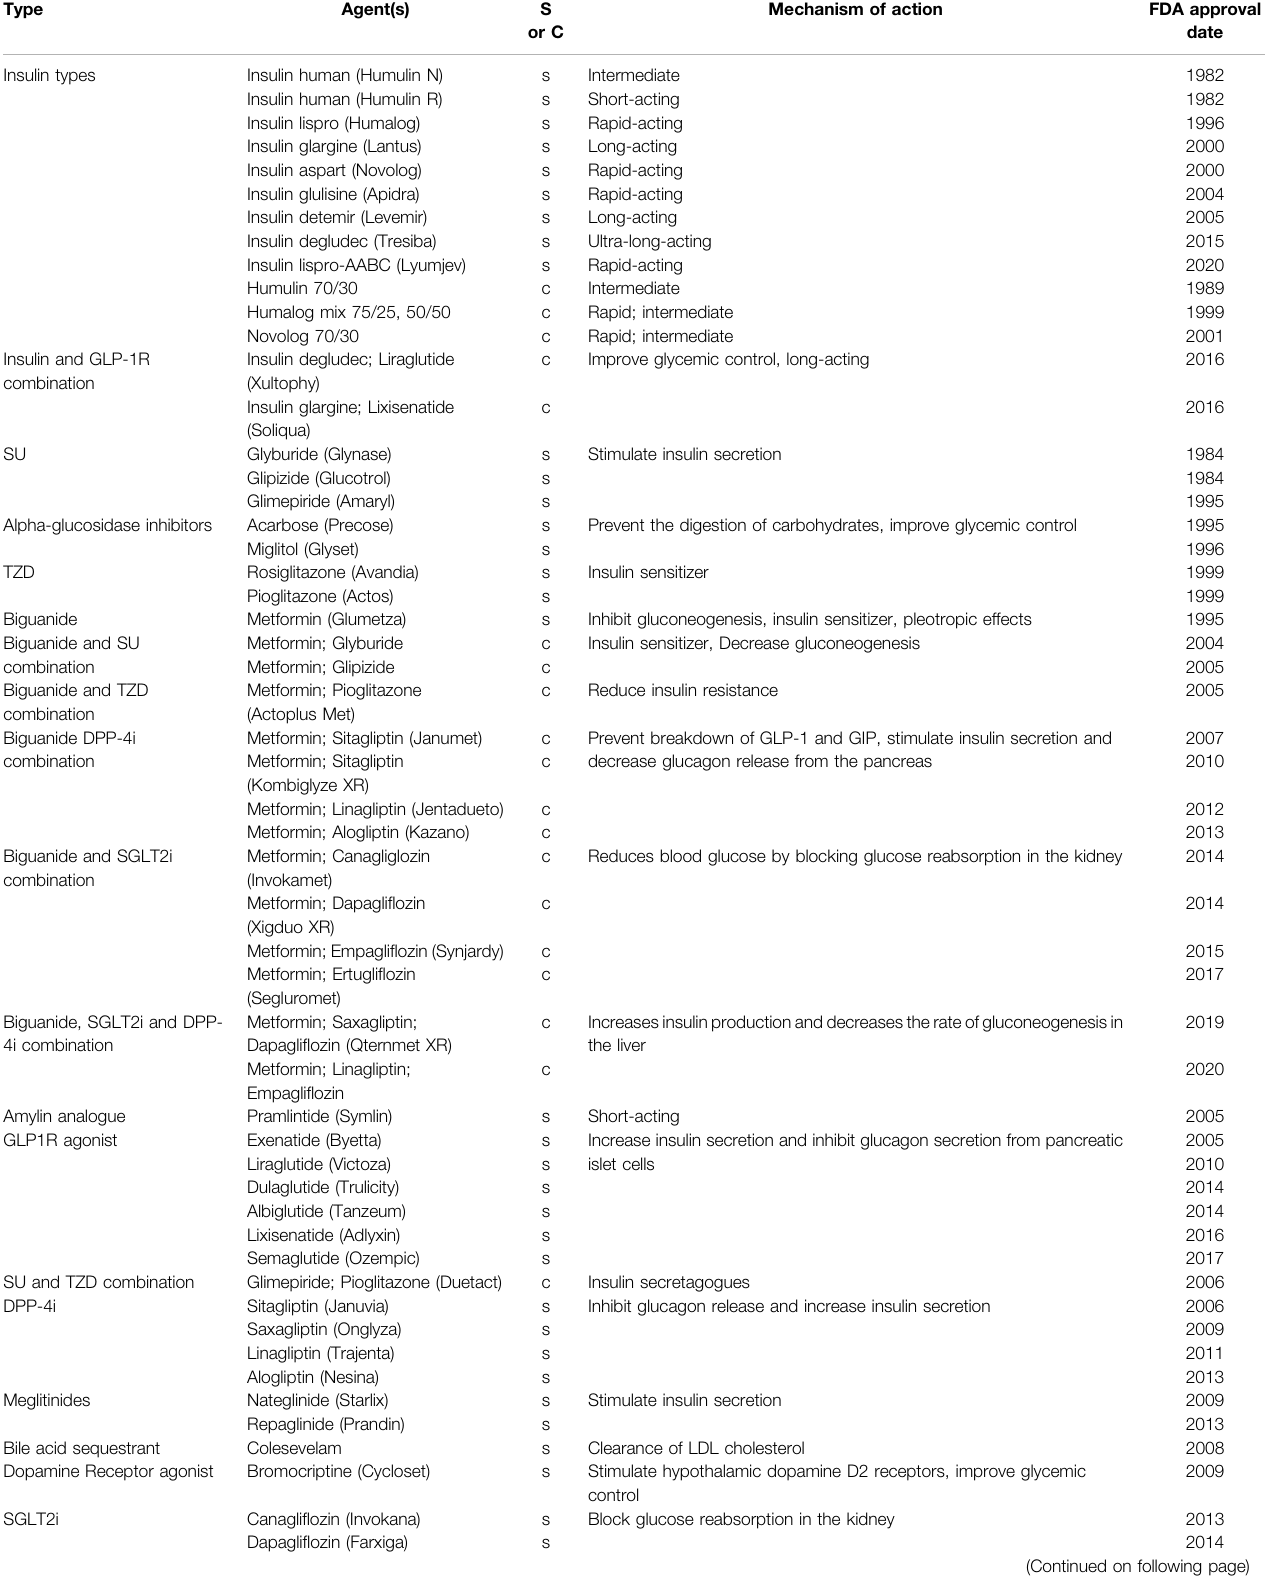
TABLE 1 | FDA-approved anti-diabetic